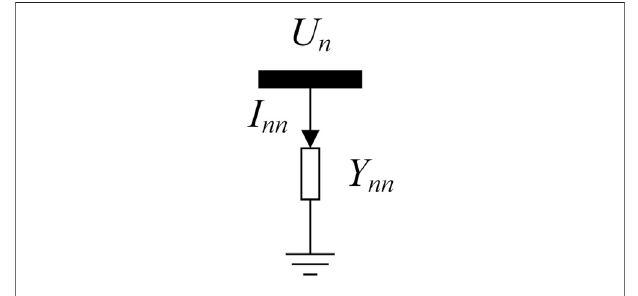
FIGURE 13 | The grounding structure.